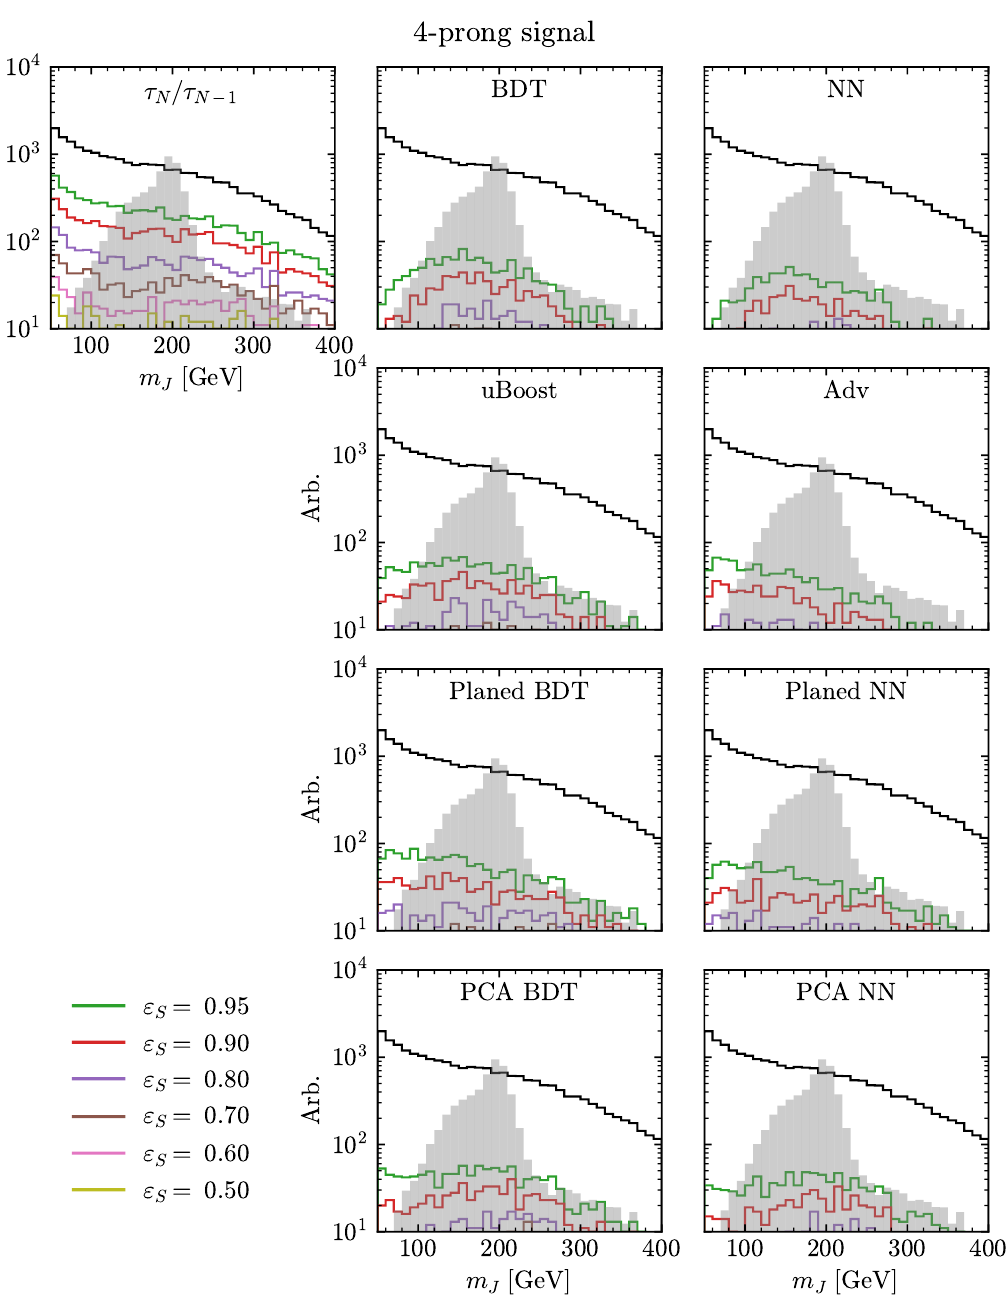
Figure 20: Comparison of all decorrelation methods to the benchmarks for the 4- prong signal. τ